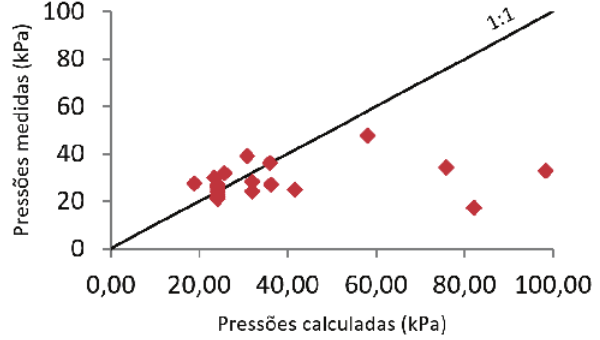
Pressões calculadas com ABNT NBR 15696:2009 versus pressões medidas para velocidade de concretagem entre 0,45 e 6,38